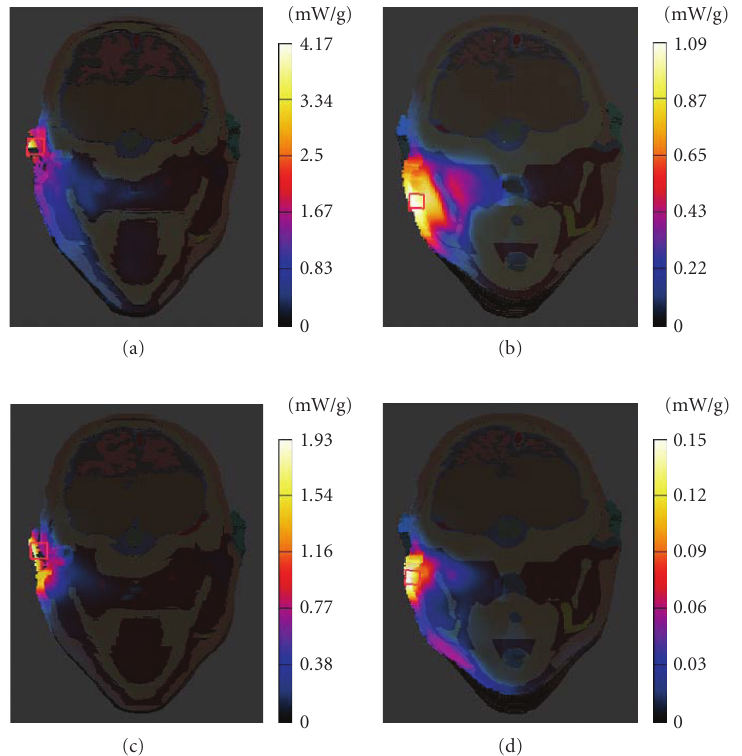
Figure 10: Sliced-distribution of the averaged peak SAR 1g in the yz -plane of the HR-EFH phantom in cases of handset models at tilt position. The antenna input powers are 0.6 W and 0.125 W for the frequencies 900 MHz and 1800 MHz, respectively. (a) Model no. 1 at 900 MHz, (b) Model no. 2 at 900 MHz, (c) Model no. 1 at 1800 MHz, (d) Model no. 2 at 1800